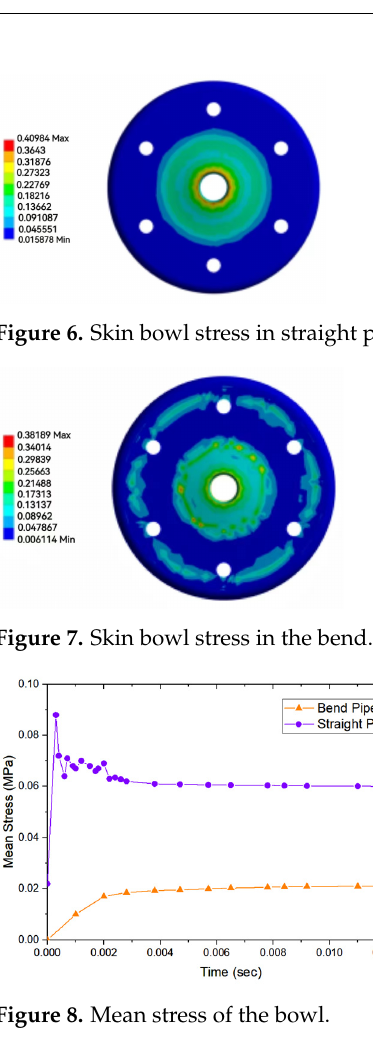
Figure 8. Mean stress of the bowl.